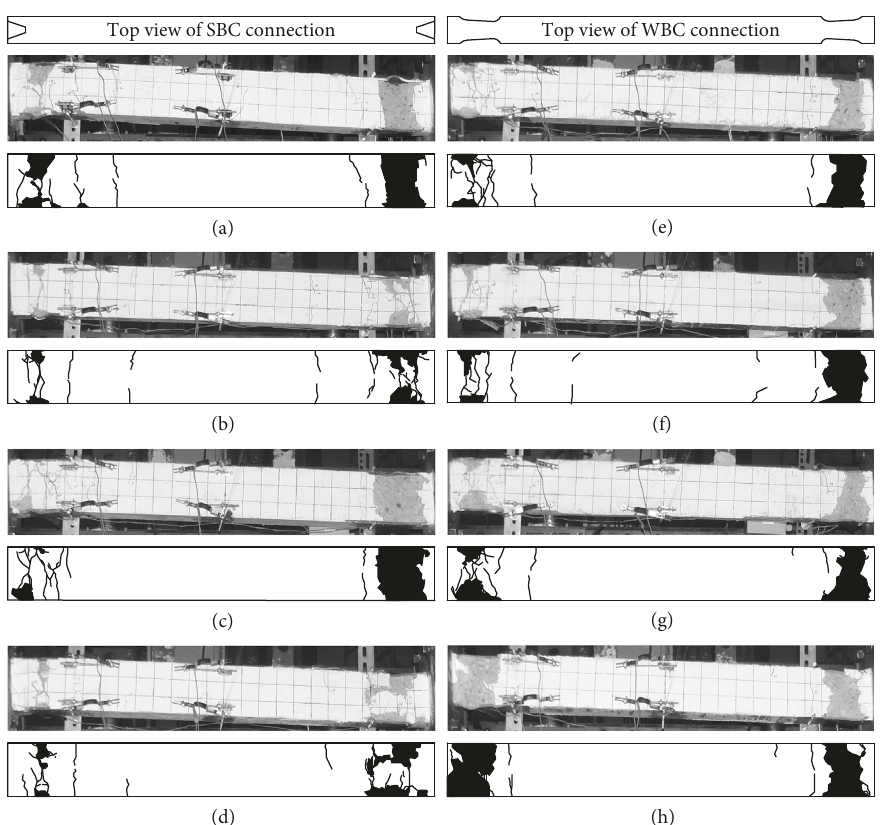
Figure 18: Condition and crack pattern of all specimens at 1st 5% drift angle cycle. (a) PS-NB. (b) PS-SC. (c) PS-MS. (d) PS-HS. (e) PW-NB. (f) PW-SC. (g) PW-MS. (h)